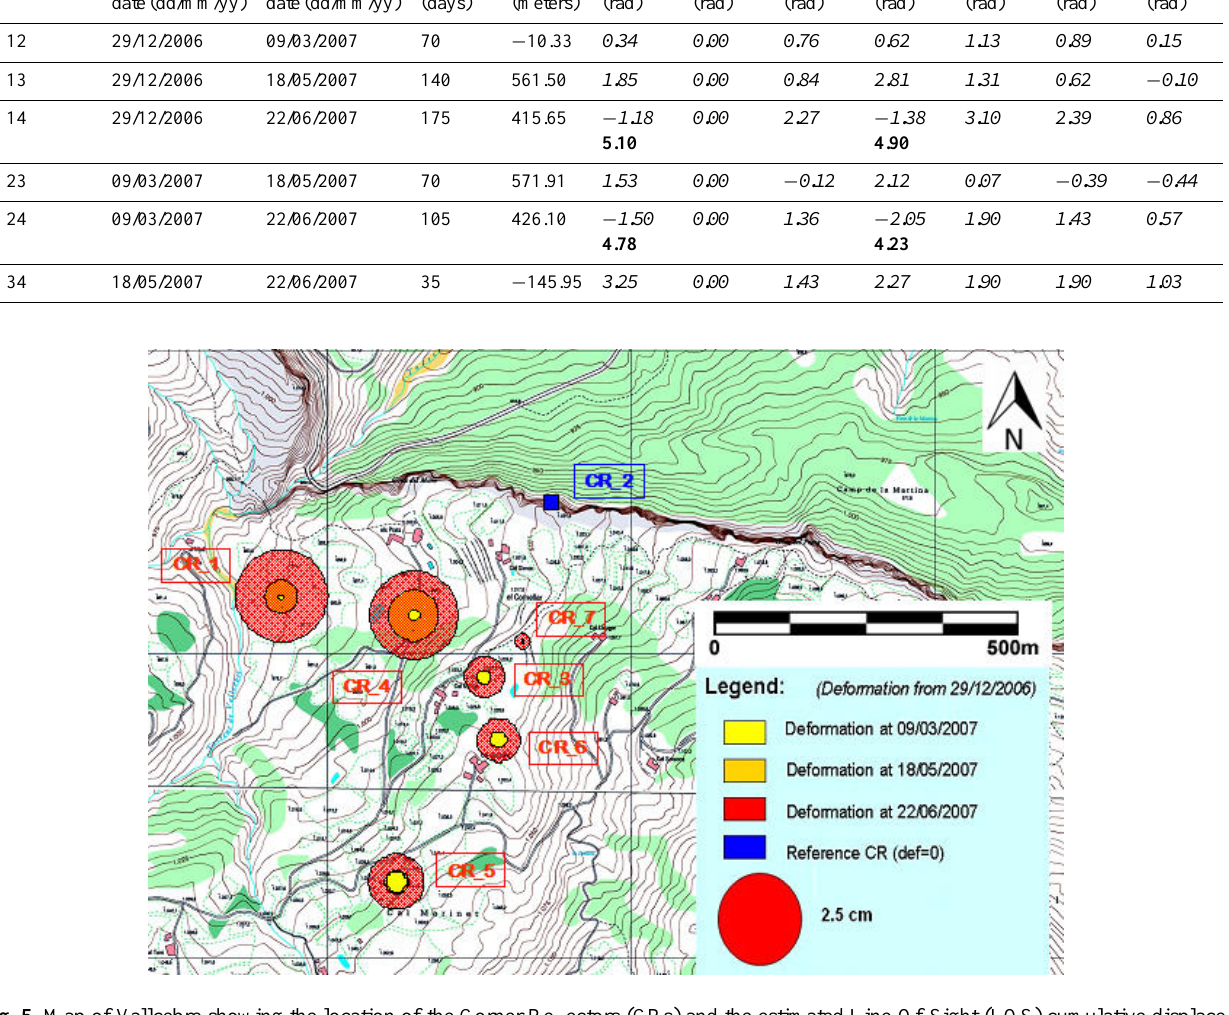
Figure 5. Map of Vallcebre showing the location of the Corner Reflectors (CRs) and the estimated Line-Of-Sight (LOS) cumulative displacements since the date of acquisition of the first image.